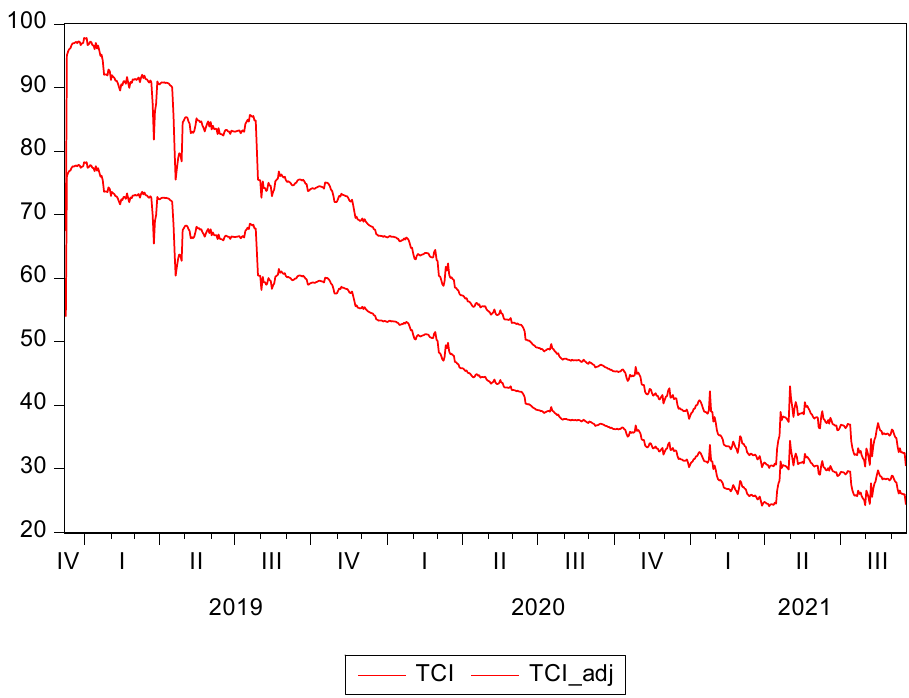
Figure 2. Total connectedness index dynamics (TCI). Note: TCI is total connectedness index and TCI_adj is the adjusted total connectedness index among the stock returns of the vaccine producers.